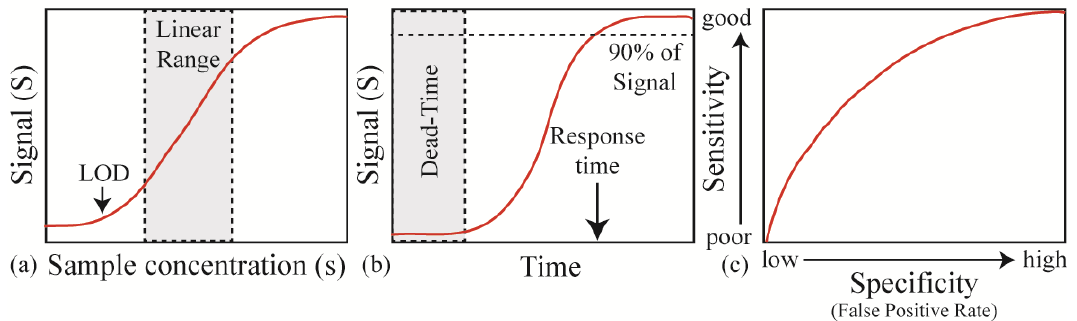
Figure 2. Overview of the key approaches for characterizing sensor performance. ( a ) One approach is to consider the sensor response (S or signal) for a given input or sample concentration (s or sample concentration). This approach would include the linear working range and the limit of detection (LOD); ( b ) Another is to evaluate the temporal behavior of the sensor, which includes parameters such as the response time and the dead-time; ( c ) Finally, the balance between specificity (or selectivity) and sensitivity can be considered. This metric is particularly important in